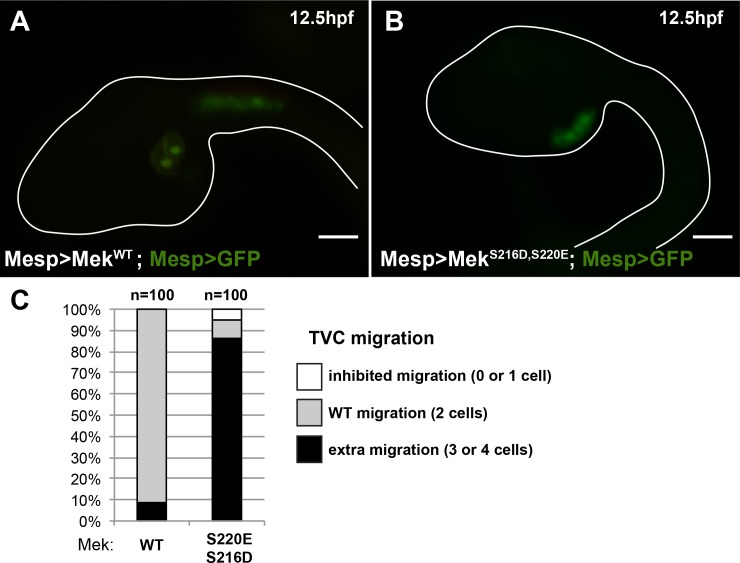
The constitutively active MEKS216D,S220E mutant is sufficient to impose a TVC identity to the whole B7.5 lineage.(A) Control late tailbud embryo showing the left side B7.5 lineage expressing GFP and a MEKWT control under the control of the Mesp enhancer. Two TVCs and two ATMs are normally induced, and TVCs migrated into the trunk. (B) Late tailbud embryo showing the left side B7.5 lineage expressing GFP and a MEKS216D,S220E mutant under the control of the Mesp enhancer. Four cells are observed as having migrated into the trunk, indicating that they have been induced to acquire a TVC fate and migrate, replicating FGF-MAPK gain-of-function phenotypes as described in (Davidson et al., 2006). (C) Proportions of embryo halves showing the indicated phenotypes. Extra migration is interpreted as ectopic induction of the TVC fate in all B7.5 lineage cells. Scale bar ~ 20 µm.